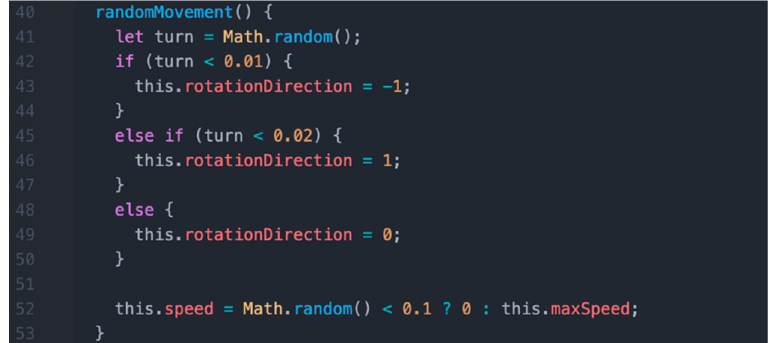
Figure 5. Balthazar’s random movement.